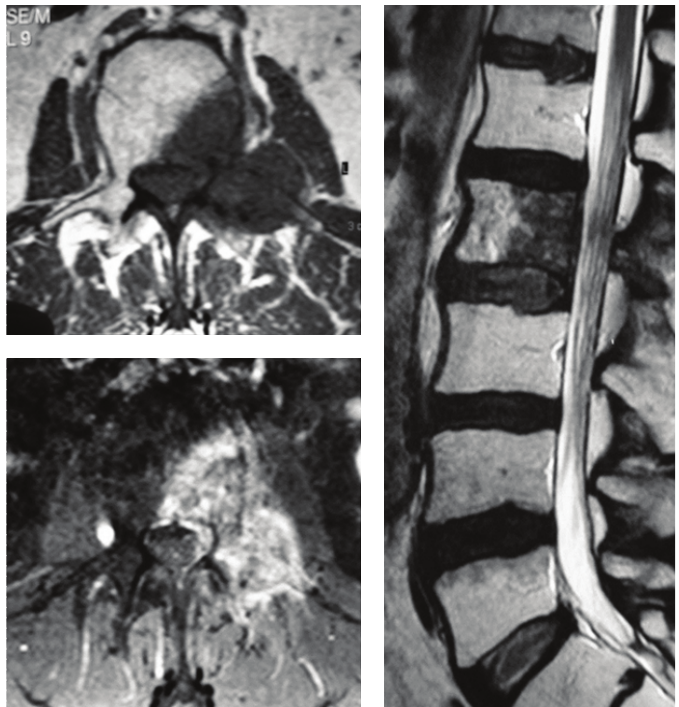
Figure 1: Preoperative MRI images showing an enhancing mass occupying the left hemivertebra, pedicle, and hemilamina of L2.